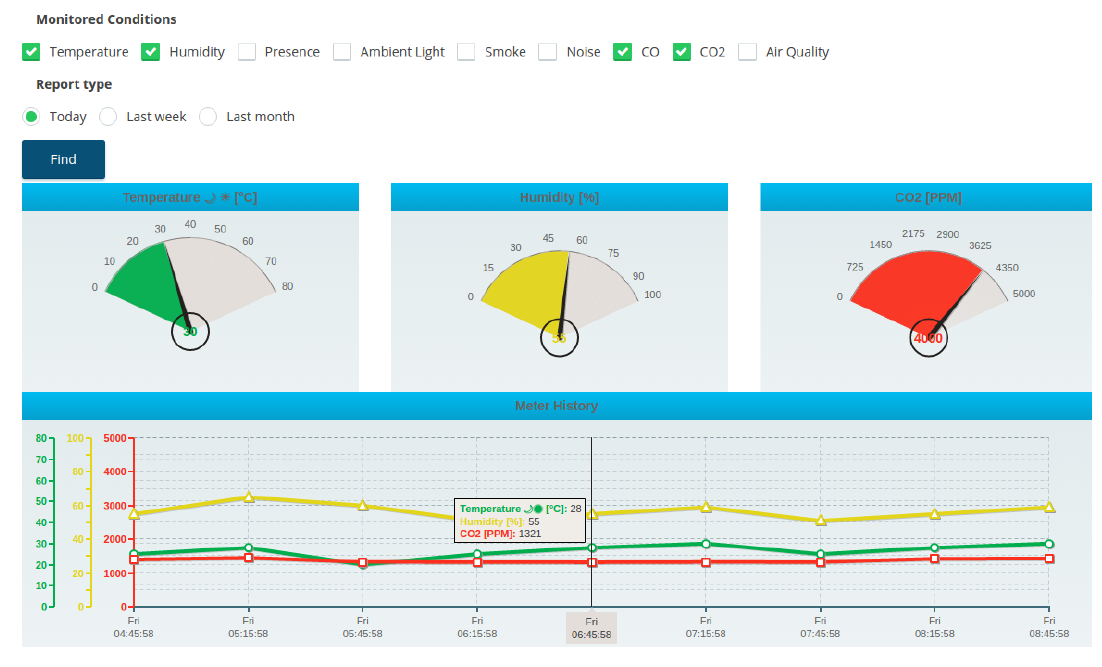
Figure 9. Example of daily ambient report for temperature, humidity and carbon dioxide.